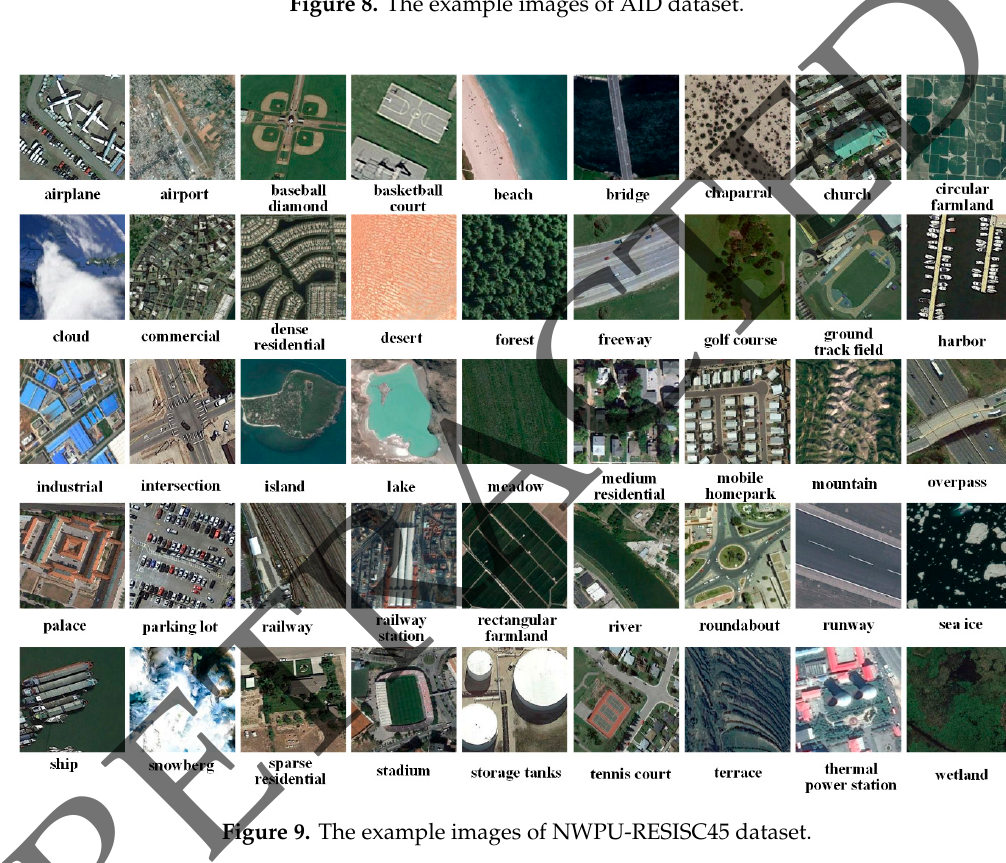
Figure 9. The example images of NWPU-RESISC45 dataset.